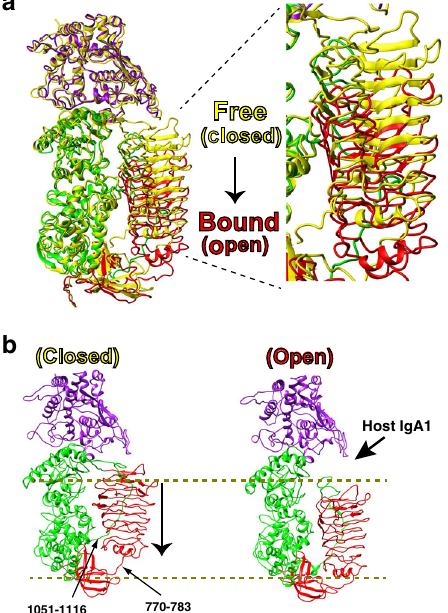
Fig. 3 Structural rearrangement of IgA1P upon IgA1 binding. a Superposition of IgA1P in both free (yellow) and bound (colored by domain as in Fig. 1d) states. A least squares superposition of IgA1P residues 1115 – 1963 was used for all C-alpha atoms, illustrating the large 10 Å shift of the entire NTD β -helix. The unbound state is referred to as “ closed ” and the bound state as “ open ” . b The 10 Å shift of the NTD β -helix is illustrated by both the free (left, closed state) and bound IgA1P (right, open